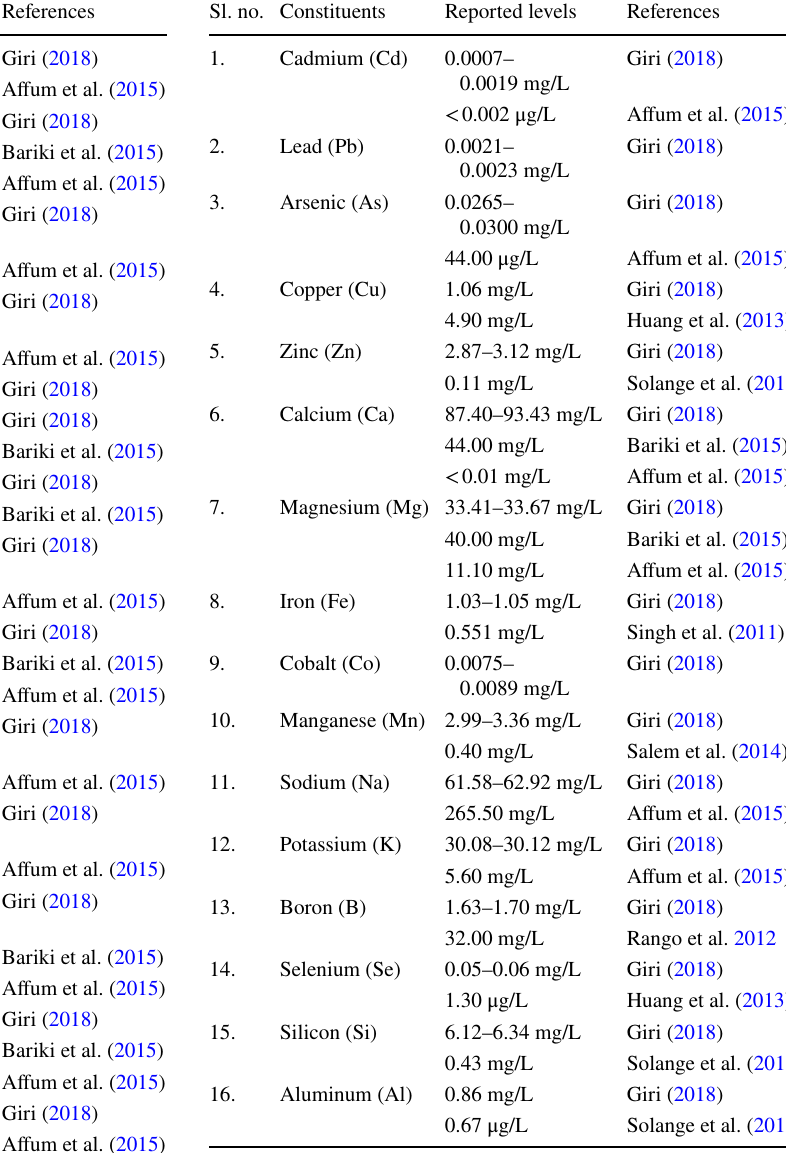
Table 1 Review of different physicochemical and microbiological Table 2 Review of different trace minerals and metals level